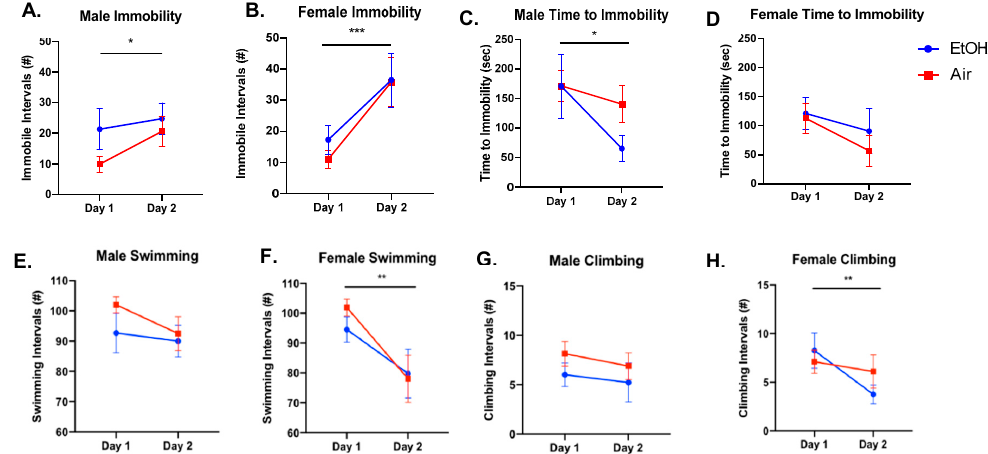
Figure 3. Frequency of immobility, climbing, swimming, and time to immobility during forced swim stress (FSS) sessions by adolescent air or ethanol (EtOH) exposure group on the first and second day of FSS sessions. Males showed a significant increase in immobile episodes ( A ) and decrease in time to immobility ( C ) on day two and no changes to climbing ( E ) or swimming behaviors ( G ). Females showed a significant increase in number of immobile episodes on day two ( B ), but no significant di ff erence in time to immobility between days ( D ). Females also showed significant decreases in both climbing ( F ) and swimming behaviors on day two ( H ). There was no e ff ect of ethanol exposure in either sex; a significant e ff ect of day denoted as * p < 0.05, ** p < 0.01 and *** p <